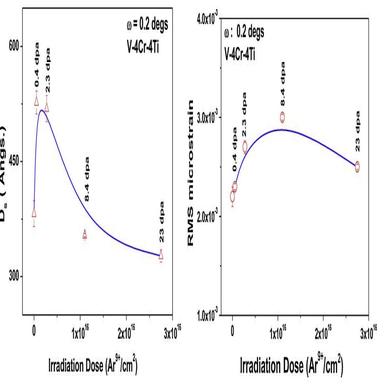
(a) & (b): Variation of coherent Domain size Ds and RMS Microstrain as a function of irradiation dose at peak damage region at V-alloy sample (as analyzed by Modified Rietveld Method).